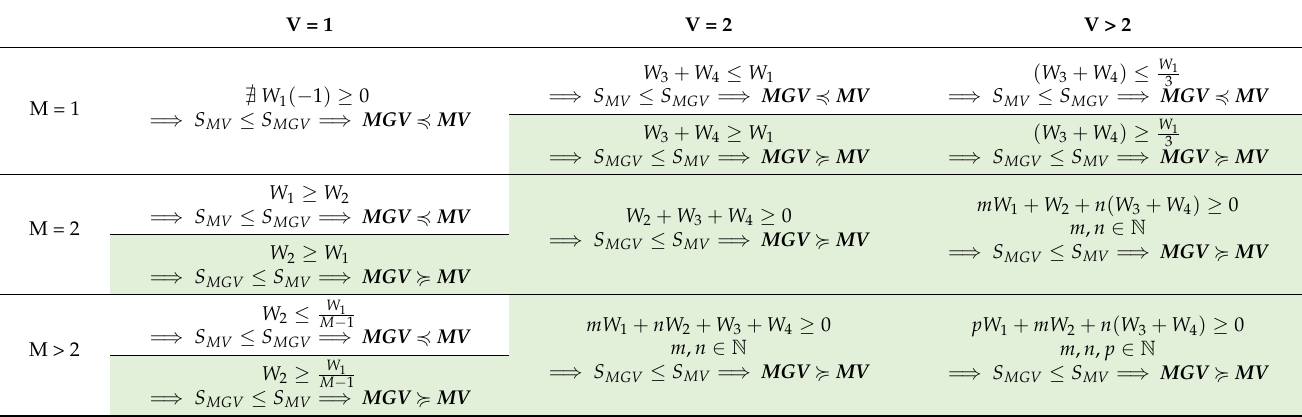
Table 7. Preference Relations of MGV over MV depending on the number of MLs (M) and views (V). MV is preferred when M = V = 1; MGV is preferred when M ≥ 2 & V ≥ 2. When M = 1 & V ≥ 2 or M ≥ 2 & V = 1 preference rotates based on weighting. MGV is preferable when weights are equal. The cases of MGV superiority are shaded. V = 1 V = 2 V >